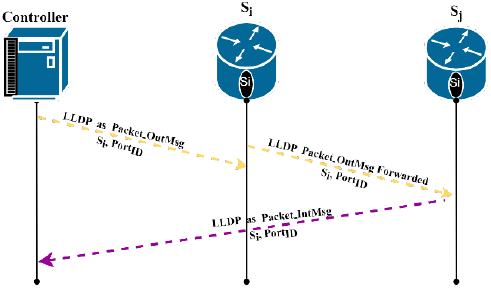
Figure 3. LLDP Signaling During Topology Discovery.